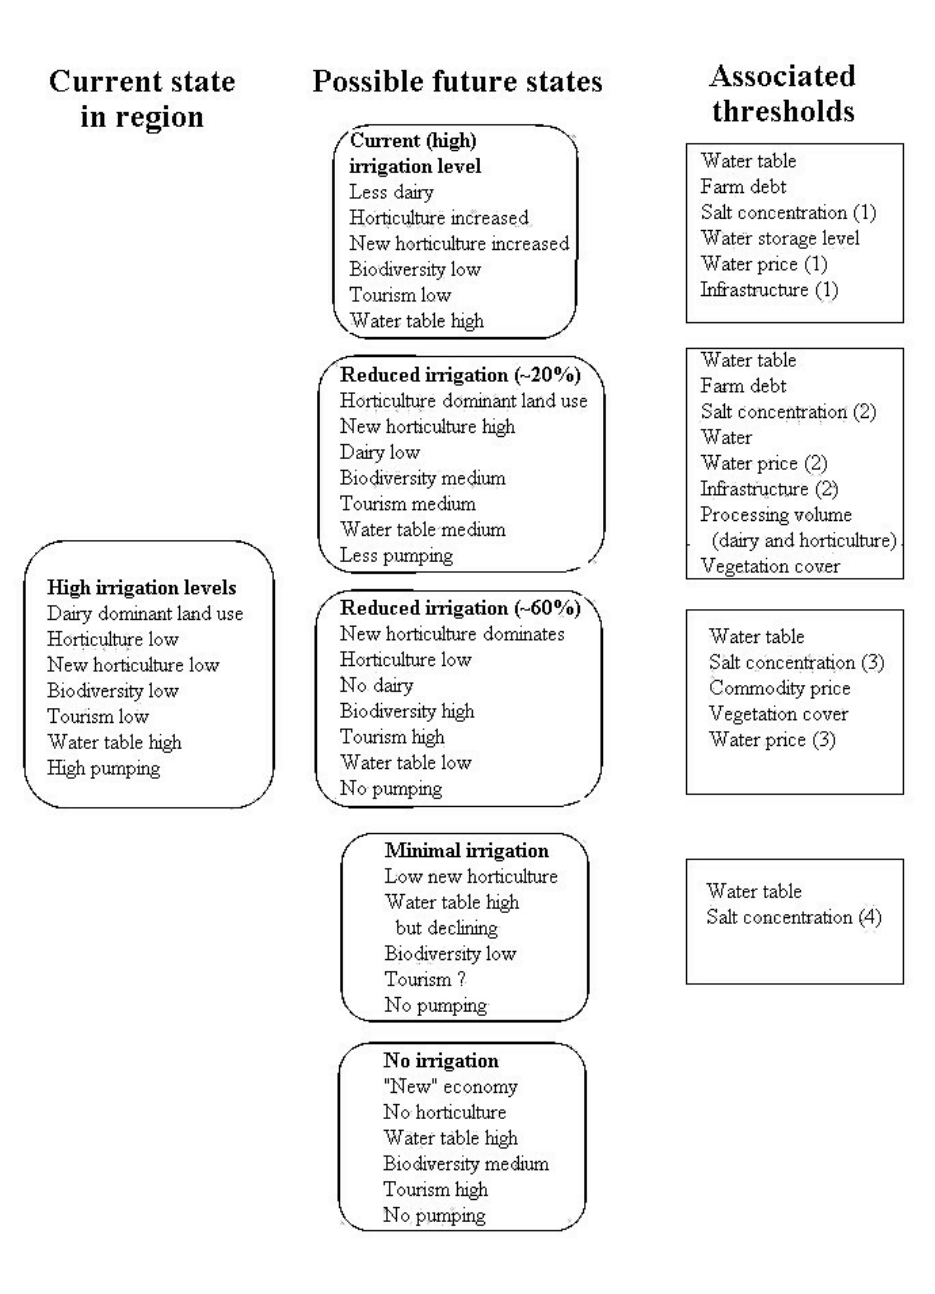
Fig. 4 . Current and possible future states in the lower Goulburn-Broken Catchment and the associated thresholds. The numbers in parentheses in the boxes for associated thresholds represent successive levels on the same controlling variable marking different threshold effects, i.e., different magnitudes or kinds of feedback